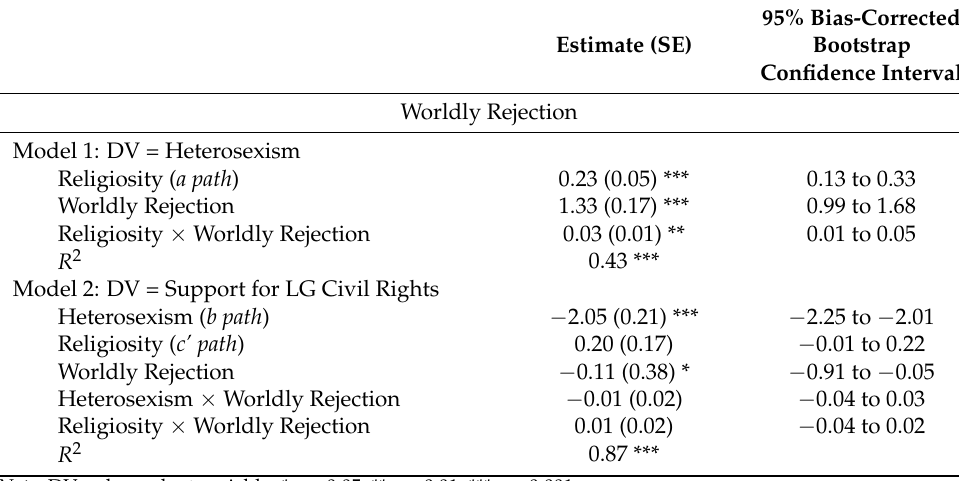
Table 6. Moderated Mediation Model Summary with Worldly Rejection.